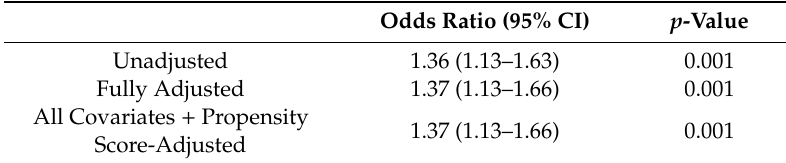
Table 3. Adjusted odds ratios for PONV of migraine after propensity score